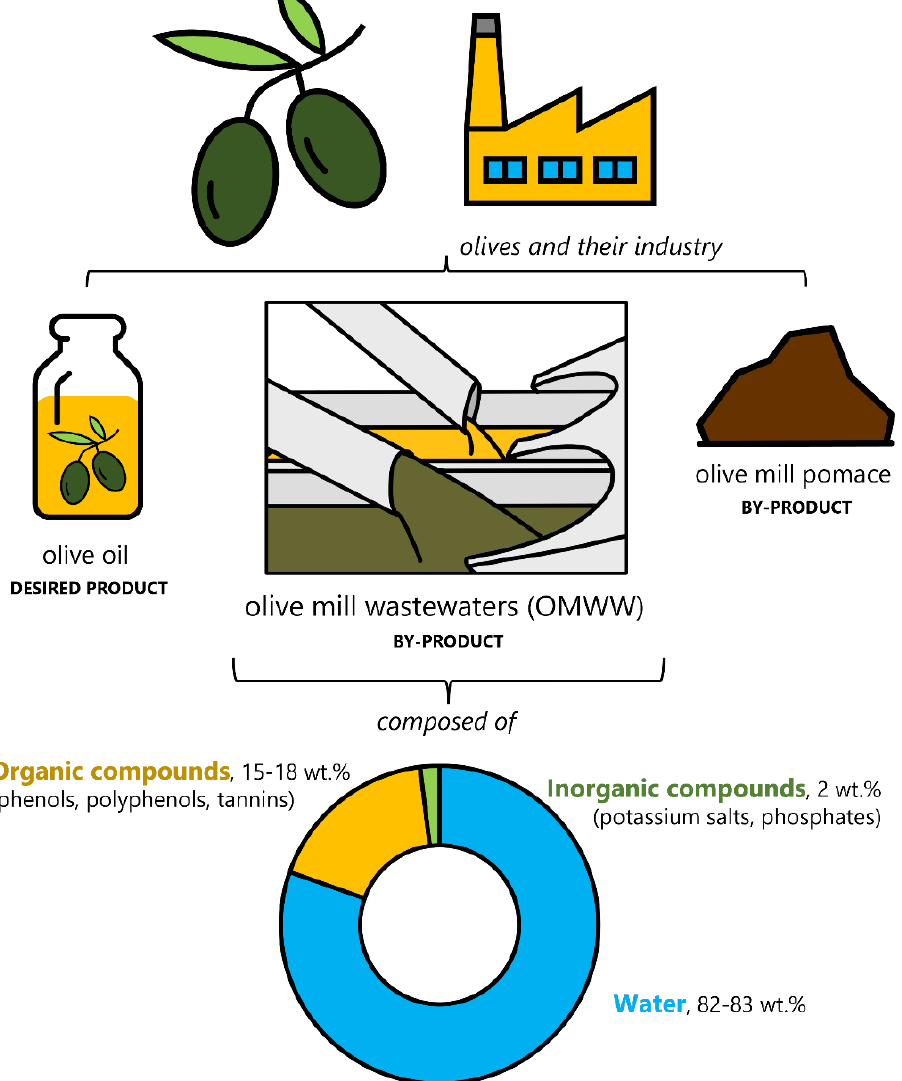
Figure 1. Scheme of products and by-products from the olive oil industry.